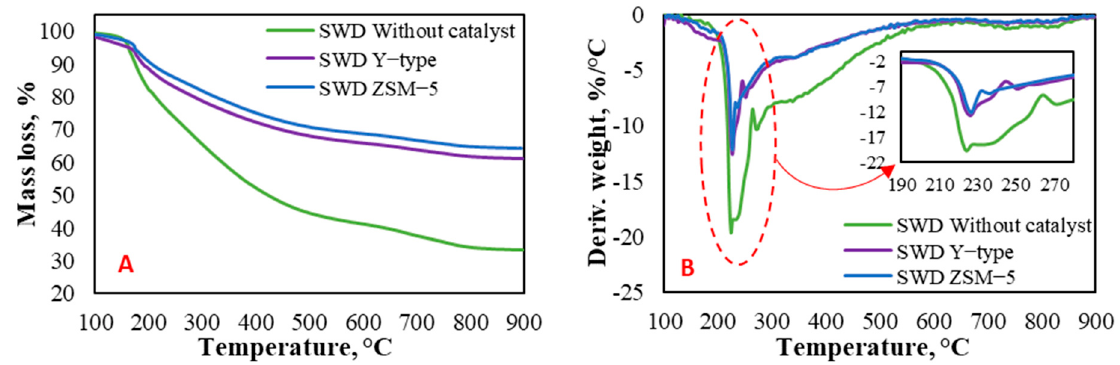
Figure 3. TGA ( A ) and DTG ( B ) curves of the seaweed sample.